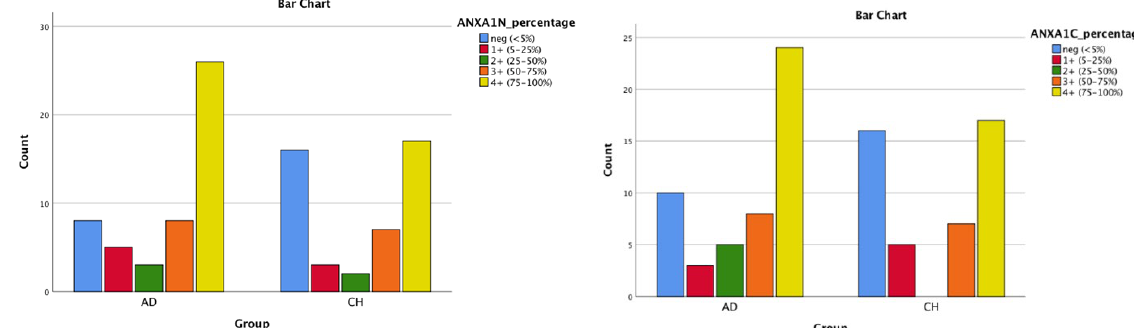
Fig. 1. Bar chart shows the comparison in Annexin1 nuclear staining in PDA and CCA.